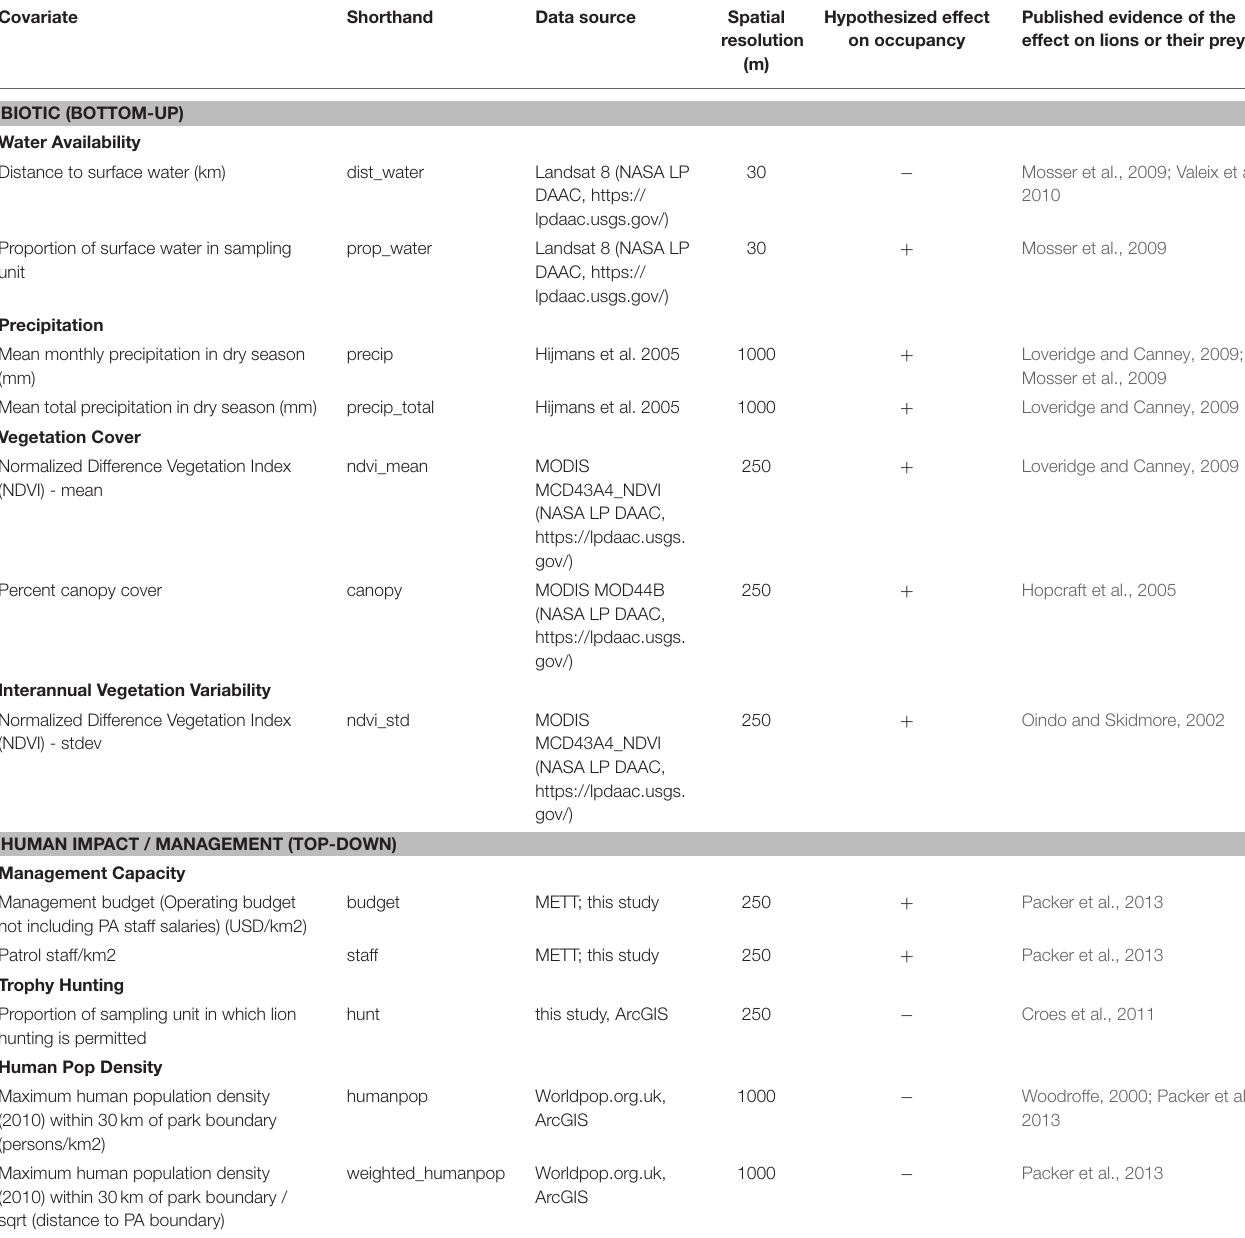
TABLE 1 | Twelve site covariates representing seven metrics hypothesized to affect lion occupancy across W-Arly-Pendjari. Covariate